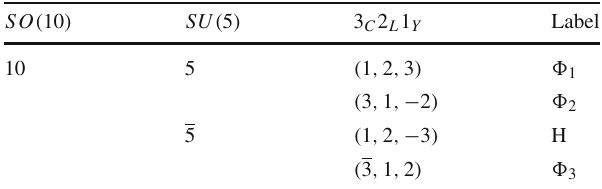
Table 2 Decomposition of the scalar 10 representation of SO ( 10 )